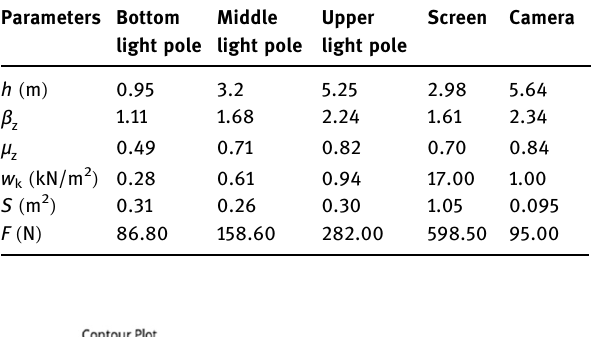
Table 2: Values of wind load Parameters